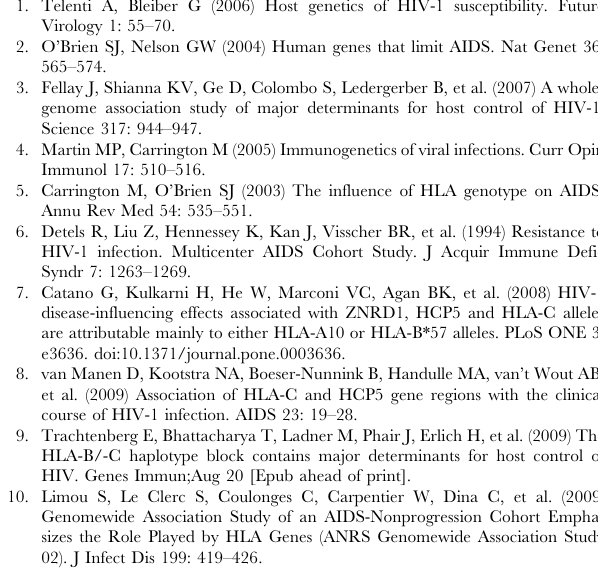
Table S10 Top 500 SNPs in the progression analysis.